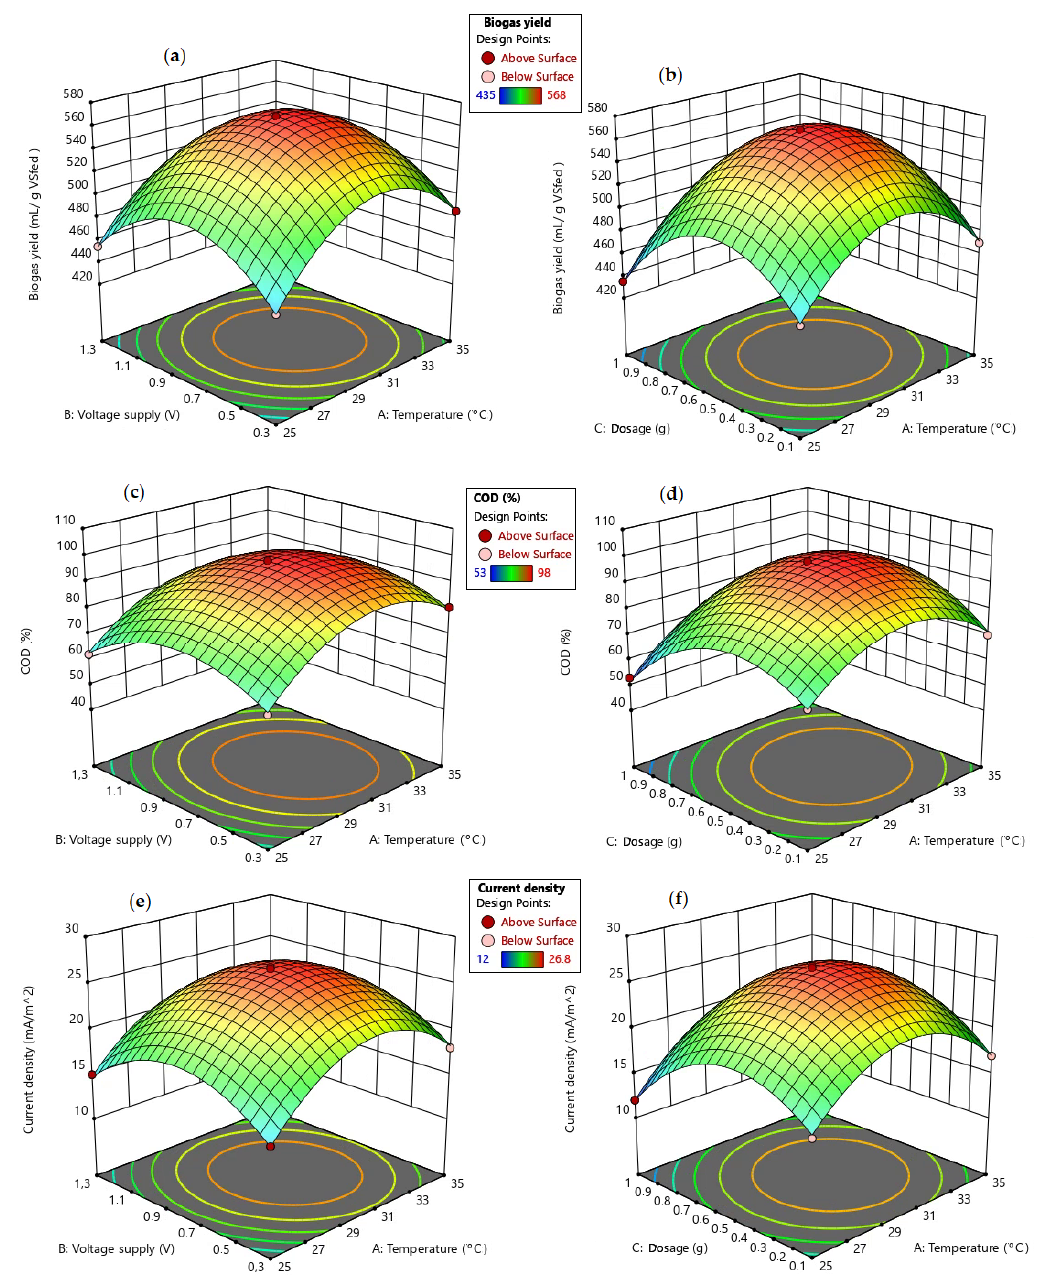
Figure 5. 3D graphs of BA and CA for ( a , b ) biogas yield; ( c , d ) %COD removed; and ( e , f ) current density, respectively.